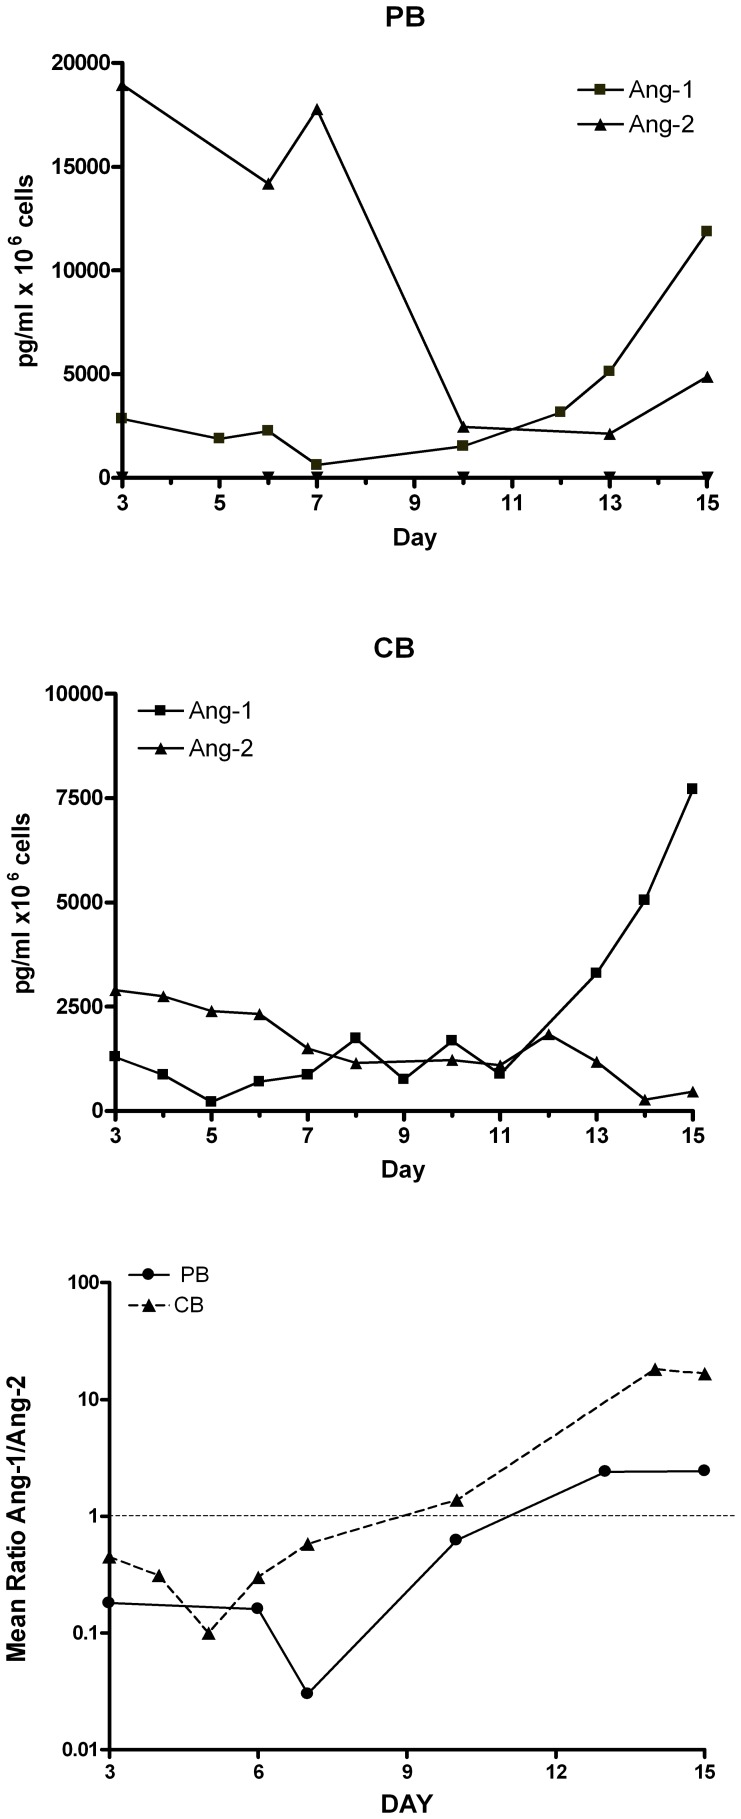
Release of angiopoietins by differentiating megakaryocytes.PB (top panel) or CB (middle panel) CD34+ cells have been grown in unilineage Mk cultures and culture supernatants have been harvested at various days of culture and evaluated for Ang-1 and Ang-2 content per 106 cells. Mean values ± SEM observed in three separate experiments are shown. In the bottom panel the ratio Ang-1/Ang-2 at various days of culture is plotted.